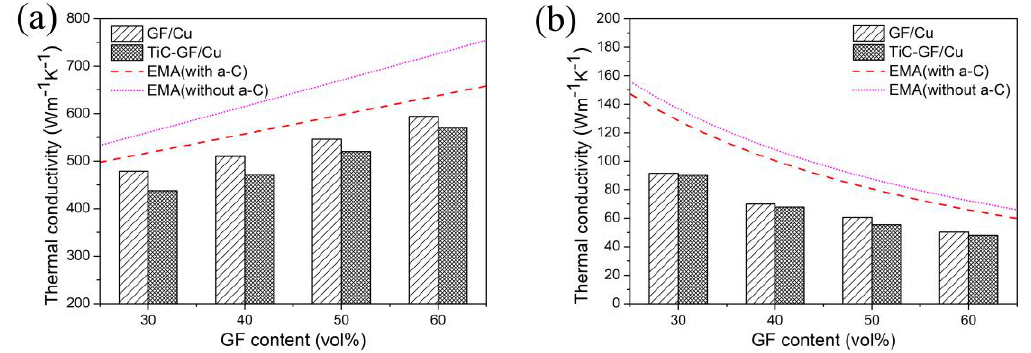
Figure 12. TC of the composites in X - Y plane ( a ), and Z direction ( b ).